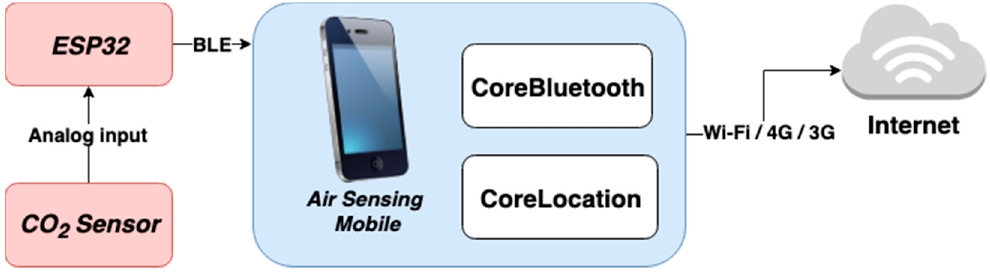
Figure 3. System communication architecture .